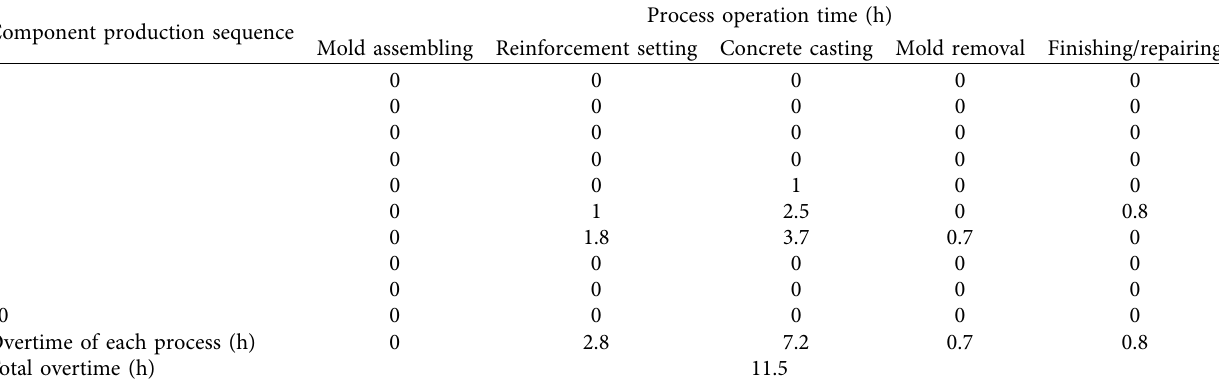
Table 6: Overtime plan for scheme (1).